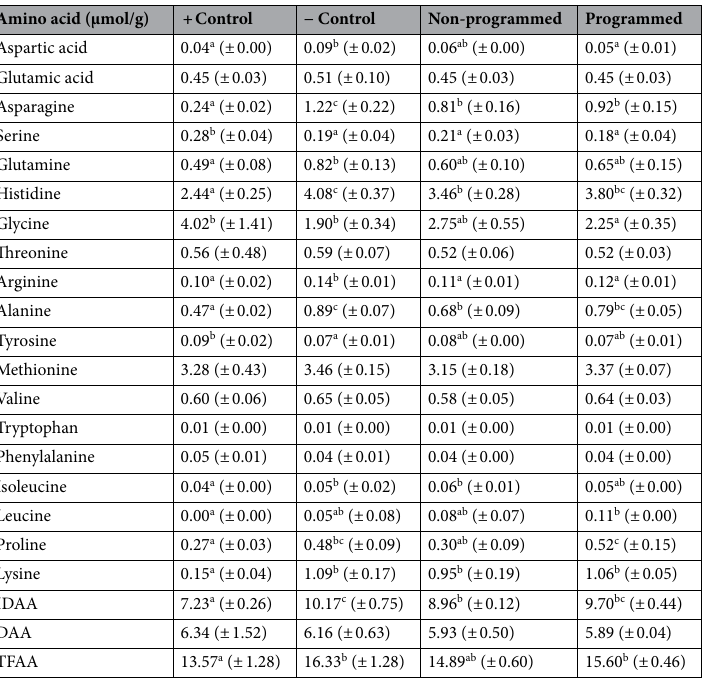
Table 6. Dietary treatment effect on the muscle concentration of free amino acids. The values presented are post-prandial levels, 3 h after feeding. Values are presented as means (± std. dev). Superscript letters indicate statistical significance between groups. The significance was determined using a One-way ANOVA and an LSD test with a p value < 0.05. Indispensable amino acids (IDAA) = Ile, Leu, Lys, Met, Phe, Thr, Trp, Val, Arg, and His. Dispensable amino acids (DAA) = Ala, Asp, Asn, Glu, Gln, Gly, Pro, Ser, and Tyr. TFAA total free amino